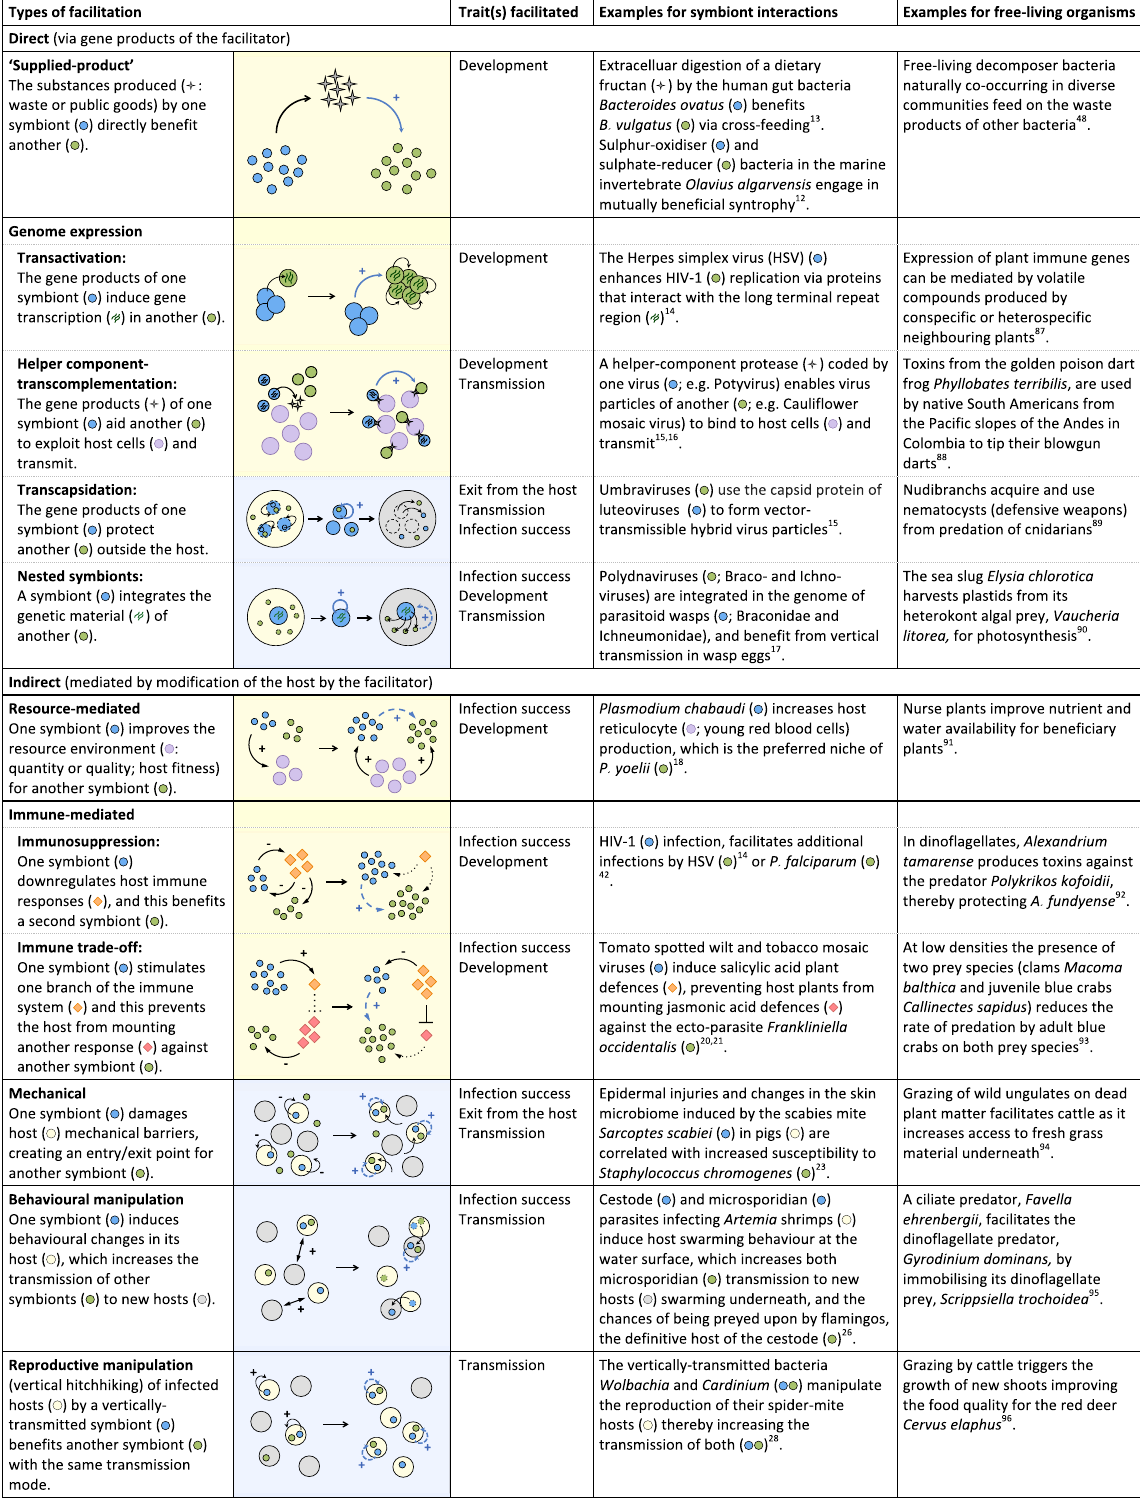
Fig. 3 Mechanisms underlying symbiont facilitation and parallels with free-living organisms. Blue circles: facilitating symbionts; green circles: facilitated symbionts; yellow shading: within-host environment; blue shading: between-host environment; grey or yellow circles: host; purple circles: resource; diamonds: host immune response; blue arrows: facilitation (solid: direct; dashed: indirect); black arrows: other types of effects (solid: enabled; dotted: cancelled). Traits facilitated are categorised as ‘ development ’ (i.e. symbiont ’ s growth or differentiation) in the within-host environment, ‘ infection success ’ (i.e. host entry or establishment) and ‘ exit from the host ’ at the interface between the within- and between-host environment, and ‘ transmission ’ in the between-host